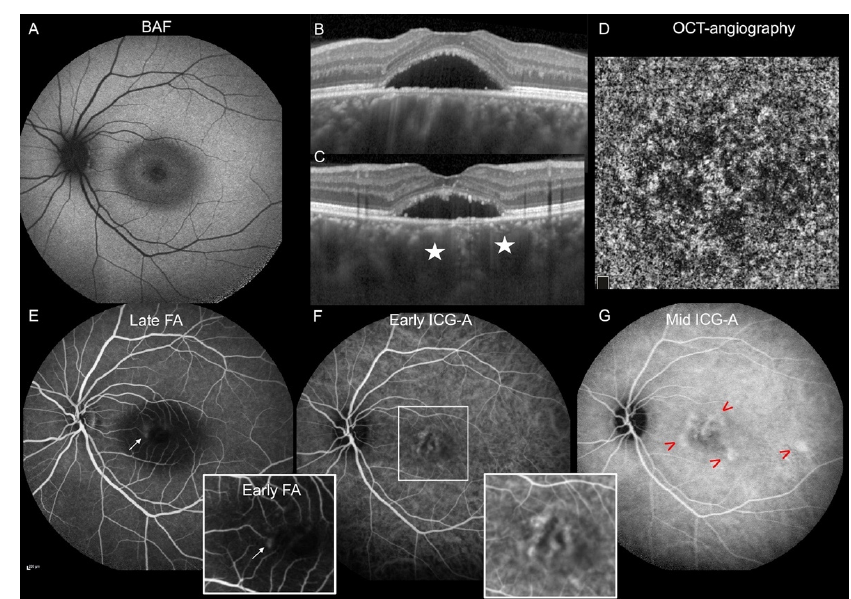
Figure 2. Multimodal imaging of a 34 ‐ year ‐ old woman with central serous chorioretinopathy in the left eye. ( A ) Blue ‐ light fundus autofluorescence shows a mixed hyper ‐ and hypo ‐ autofluorescent area at the macular serous retinal detachment (SRD). ( B , C ) The horizontal ( B ) and vertical ( C ) enhanced ‐ depth ‐ imaging (EDI) ‐ OCT scans centered on the fovea show a macular SRD associated with dilated choroidal vessels (stars). ( D ) OCT ‐ angiography at the level of the choriocapillaris shows no macular neovascularization. ( E ) Late ‐ phase fluorescein angiography (FA) shows one focal leak (arrow). Insert: early ‐ phase FA showing the focal leak (arrow). ( F ) Early ‐ phase indocyanine green angiography (ICGA) shows dilated macular choroidal veins magnified in the insert. ( G ) Mid ‐ phase ICGA shows multifocal hyperfluorescent plaques (arrrowheads).